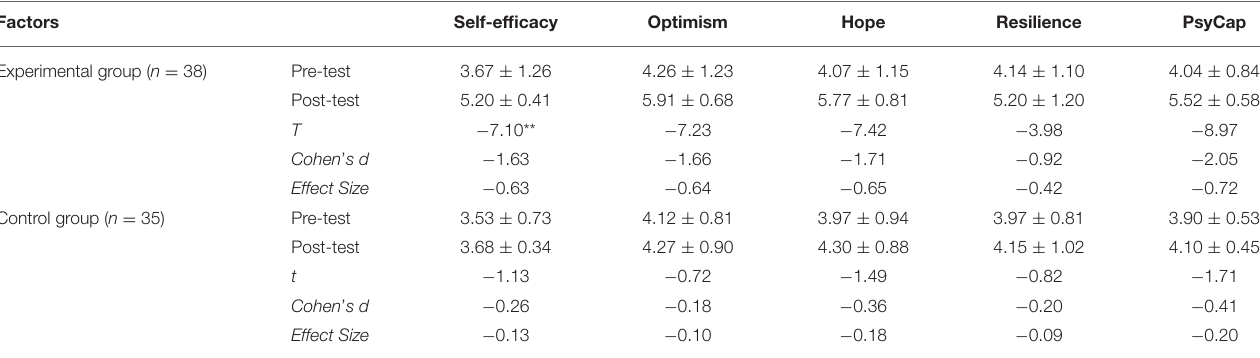
TABLE 7 | PsyCap of two groups at different test sessions (M ±